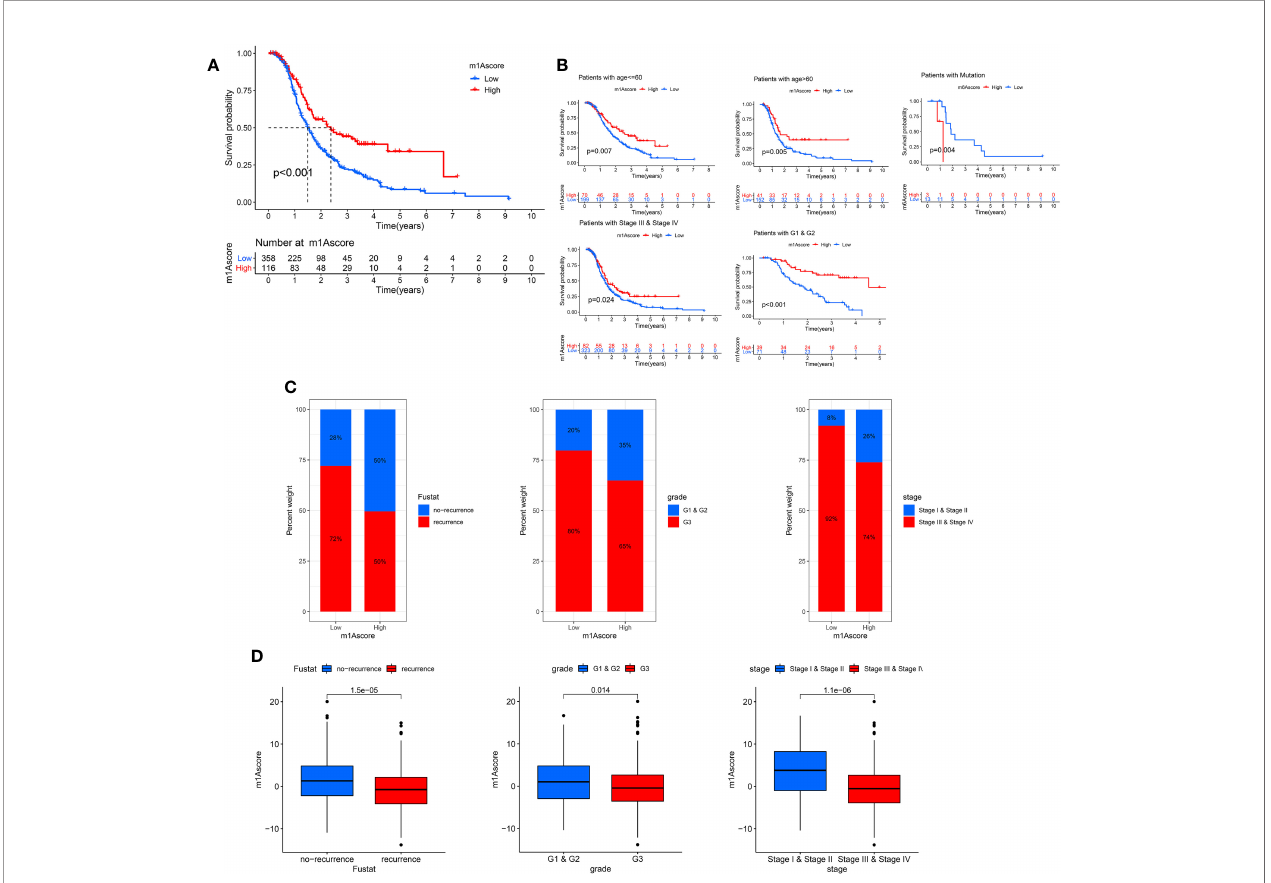
FIGURE 6 | Characteristics of m1A modi fi cation in OC patient subtypes. (A) Survival analyses of low and high m1Ascore patient groups in OC cohort using Kaplan- Meier curves. (B) Kaplan-Meier curves depicted the survival difference between low and high m1Ascore in the strati fi ed analysis of OC patients, including age, grade, stage, and BRCA mutation. (C) The proportion of patient survival status, stage and grade in high and low m1Ascore groups. (D) Boxplots for m1Ascore between different characteristics OC patients, including patient survival status, stage and